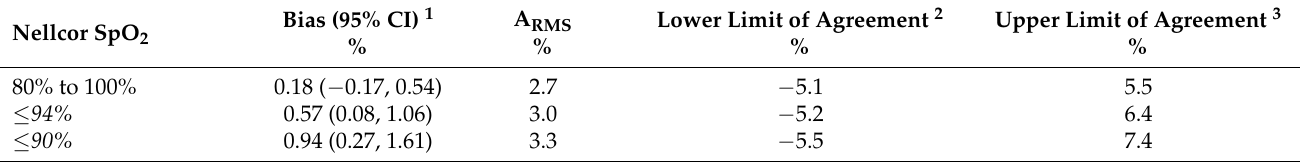
Table 3. SpO 2 . Mean error (bias) and accuracy (A RMS ) of the BrOxy M, in the whole sample and in subjects with defined